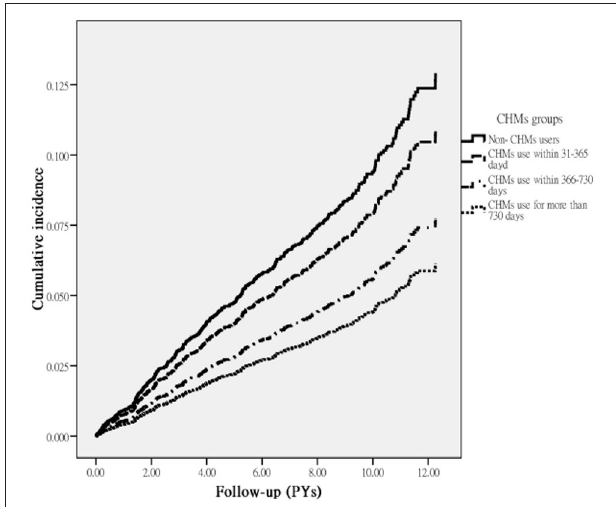
FIGURE 2 | Cumulative incidence of HL in RA patients with and without receiving CHM treatment during the study period (Log-rank test, p <